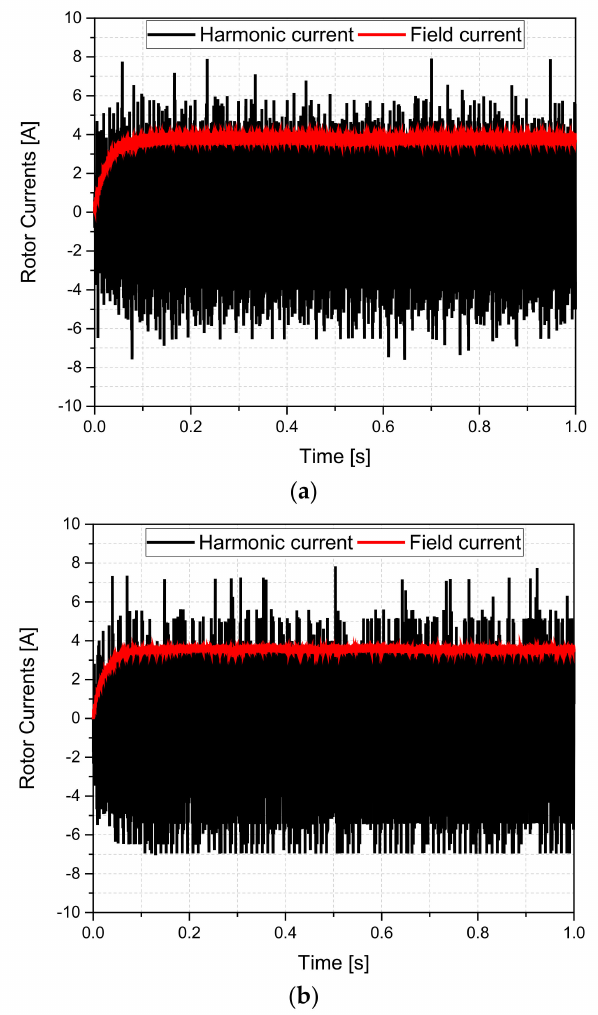
Figure 10. Rotor currents for the employed machine model using the ( a ) customary, and ( b ) proposed BL-WRSM topologies based on sub-harmonic field-excitation